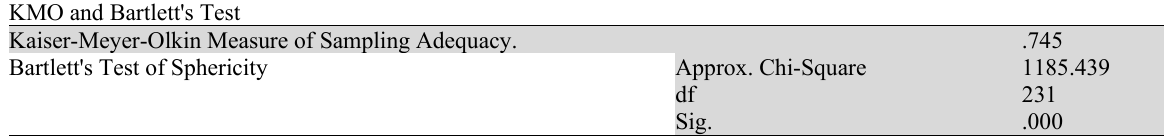
KMO and Bartlett's tests for Failure Factors KMO and Bartlett's Test Kaiser-Meyer-Olkin Measure of Sampling Adequacy.